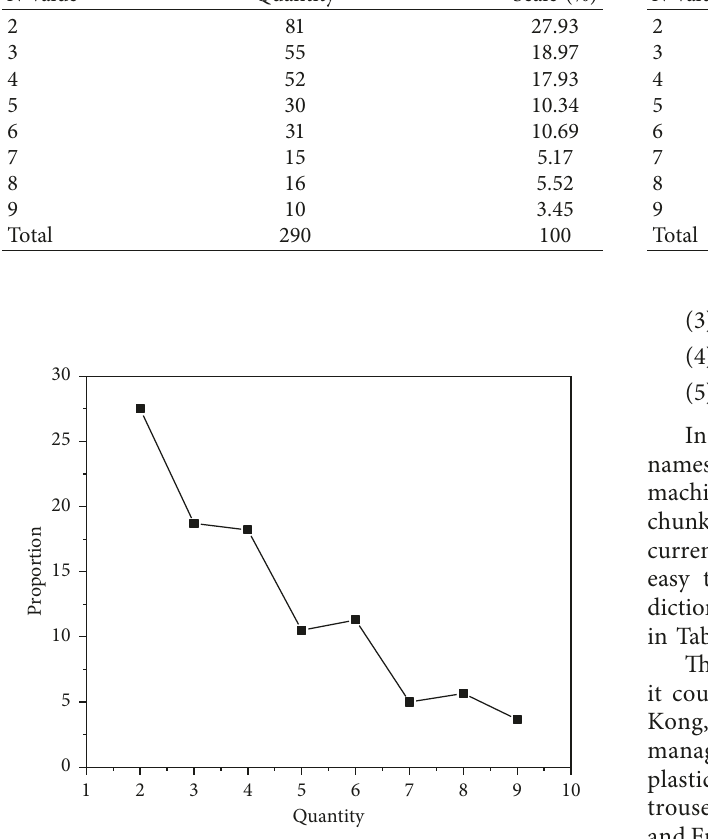
Figure 3: Ratio of N values of candidate chunks automatically extracted.